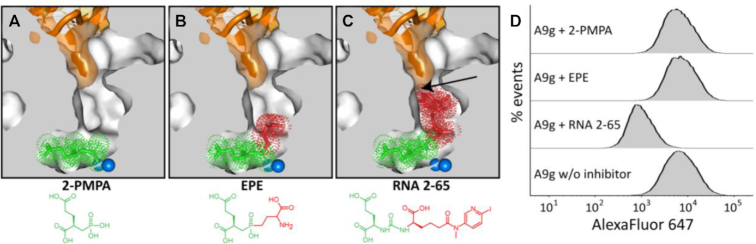
Inhibitors with bulky non-prime functionalities outcompete binding of A9g to PSMA. (A–C) Superposition of the PSMA/A9g complex and PSMA complexes with 2-PMPA (PDB code 2JBJ; panel A), EPE (PDB code 3BI0; panel B) and RNA 2–65 (PDB code 6H7Z; panel C). All complexes were superposed on corresponding Cα atoms. PSMA is shown in cross section (gray) revealing the internal inhibitor binding cavity (white). A9g is shown in semi-transparent surface representation (orange), the P1 part of inhibitors is colored red, and the zinc-binding group together with the P1′ part are colored green. A steric clash between A9g and the bulky nonprime functionality of RNA 2–65 is indicated by an arrow. The active-site zinc ions are shown as blue spheres. (D) Flow cytometry analysis of competition of A9g and PSMA-specific inhibitors. PSMA-positive PC3-PIP cells were preincubated in the presence of 1 μM inhibitor and 100 nM Alexa Fluor647-labeled A9g aptamer was added to the cell suspension. Aptamer binding was analyzed using an LSRFortessa flow cytometer.